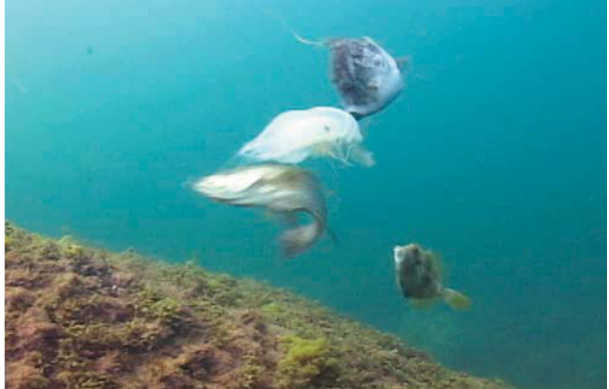
Fig. 3. A couple of planehead filefish ( Stephanolepis hispidus ) nibbling on the jellyfish umbrella caused the rough scads to leave momentarily their shelter, one of them being immediately preyed on by the comb grouper (seen here charging beneath the jellyfish, at